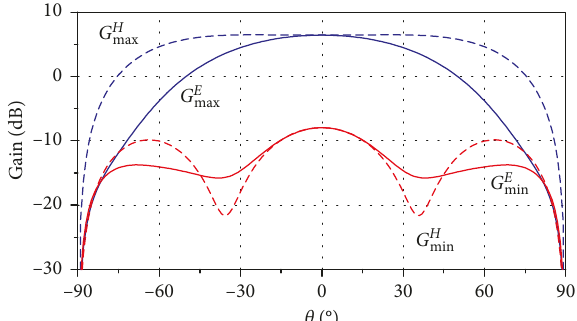
Figure 3: Gain patterns of the EFA with maximum and minimum radiation efficiencies.